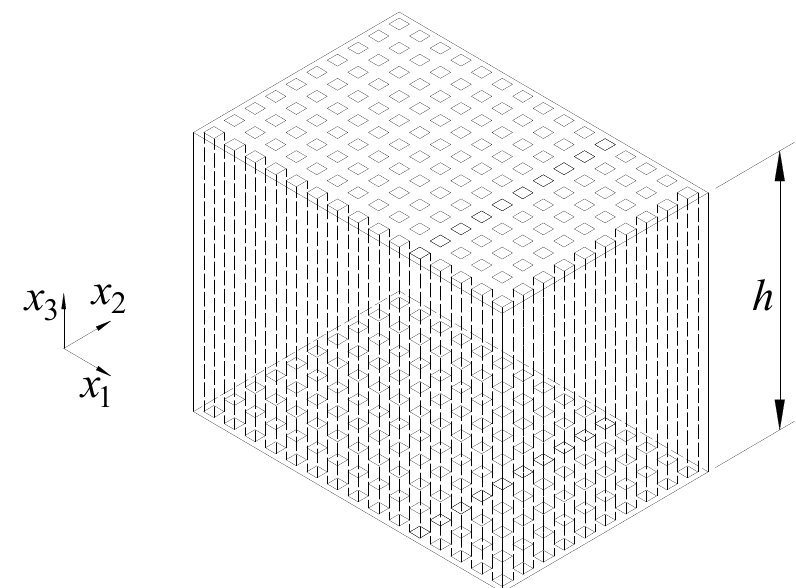
Figure 8. Three-dimensional schematic of the 1-3 type cement-based piezoelectric composite.